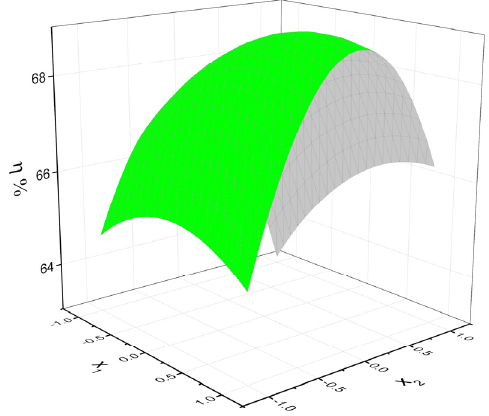
Figure 3. Yield map obtained for molecule IX.